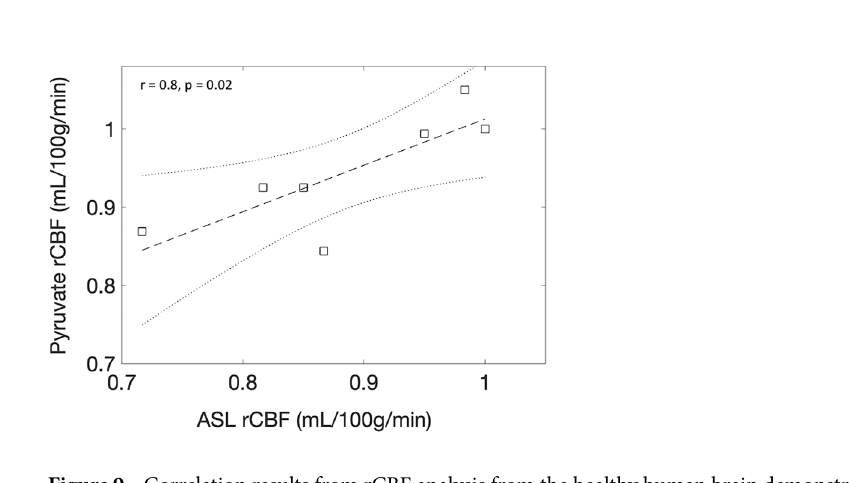
Figure 9. Correlation results from rCBF analysis from the healthy human brain demonstrating a strong correlation between ASL rCBF and pyruvate